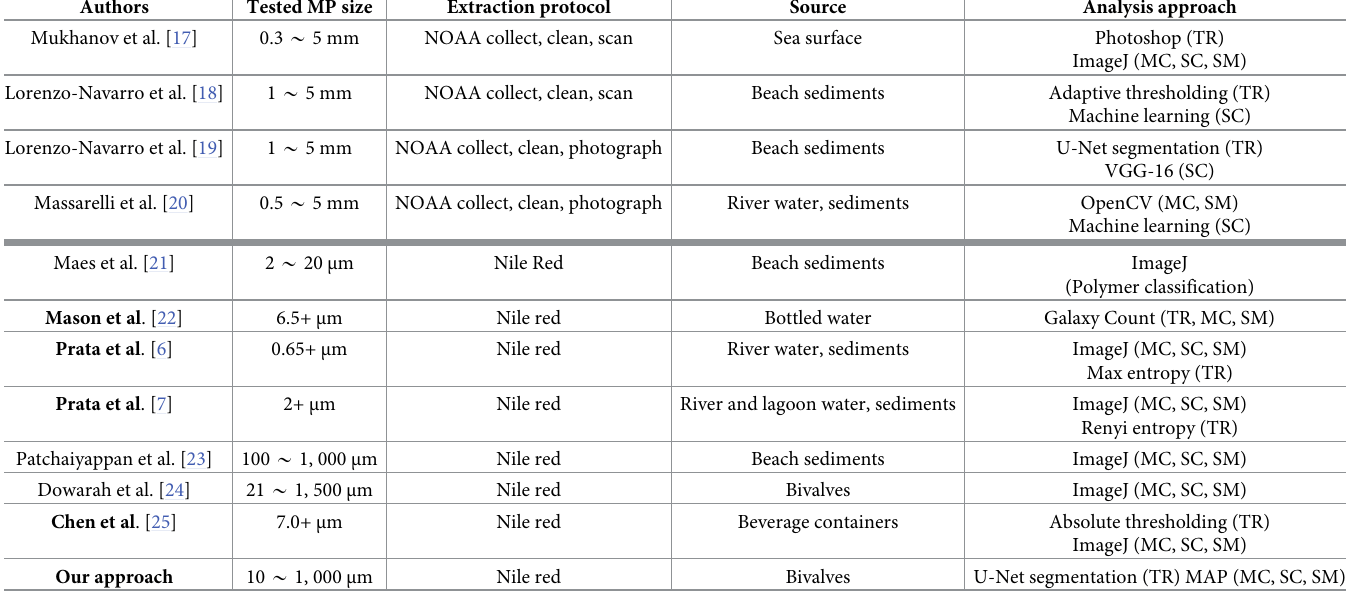
Table 1. Literature reports that describe image-based methods for MP analysis. Highlighted (bold) papers made applications publicly available to other researchers. NOAA protocol stands for National Oceanic and Atmospheric Administration protocol [16].